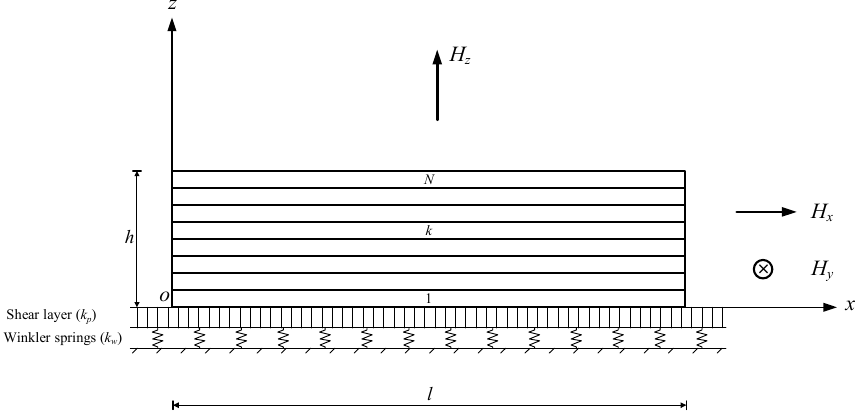
Figure 1. Schematic of a functionally graded graphene nanoplatelet reinforced nanocomposite (FG-GPLRC) beam resting on an elastic foundation in magnetic fields.